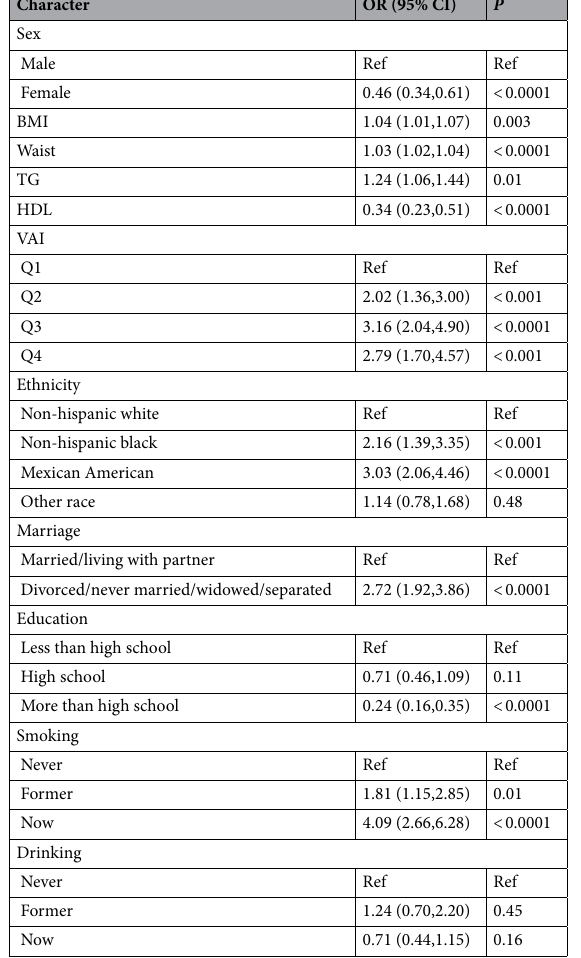
Table 3. Univariate analysis of variables associated with the presence of periodontitis. BMI: body mass index, WC waist circumference, TG triglycerides, VAI visceral adiposity index, HDL high-density lipoprotein